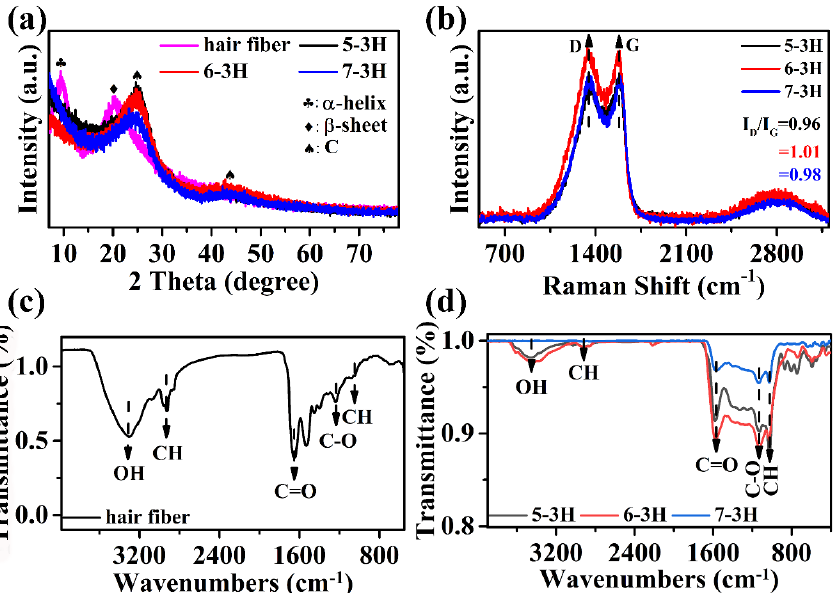
Figure 3. ( a ) XRD patterns of hair, 5 − 3H, 6 − 3H, and 7 − 3H; ( b ) Raman spectra of 5 − 3H, 6 − 3H, and 7 − 3H; ( c ) FT − IR spectrum of hair; ( d ) 5 − 3H, 6 − 3H, and 7 − 3H. 3.2. Gas sensing Performances of 5 − 3H, 6 − 3H, and 7 −